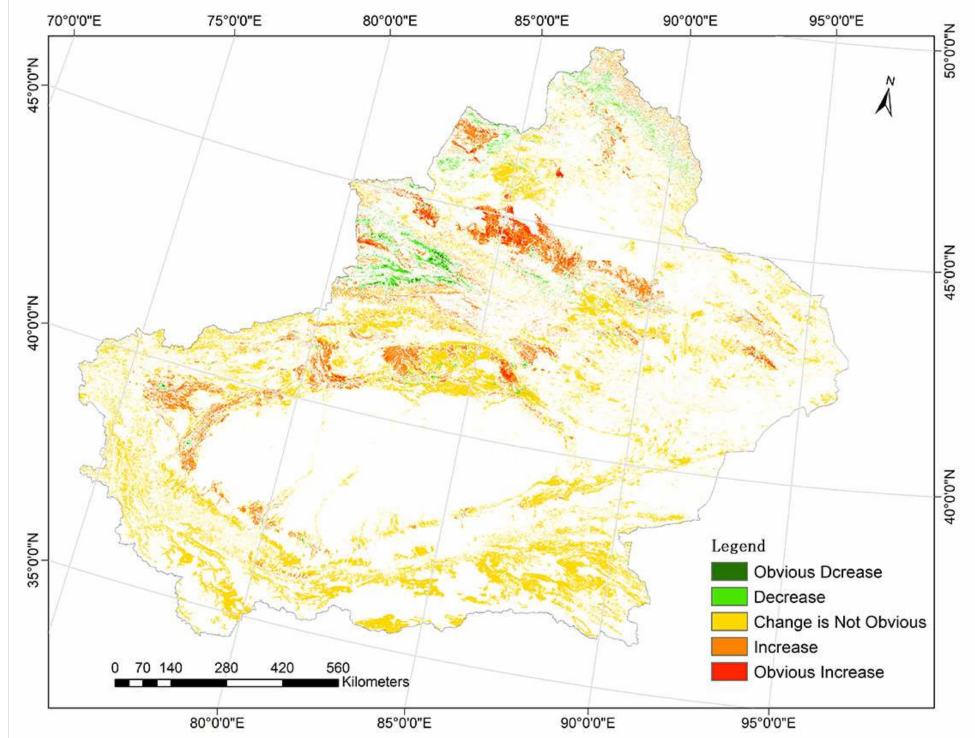
Figure 4. The spatiotemporal trend of NPP based on a Mann–Kendall test in Xinjiang from 2000 to 2019.